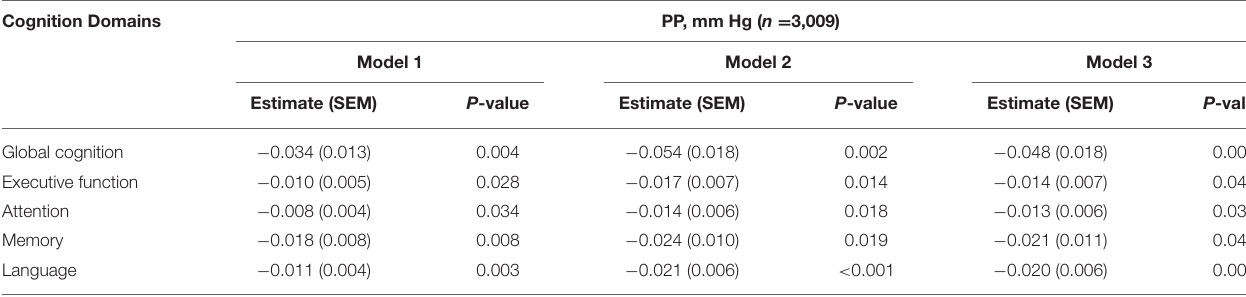
TABLE 3 | Association between continuous PP and summary cognition domains in SPRINT-MIND participants. Cognition